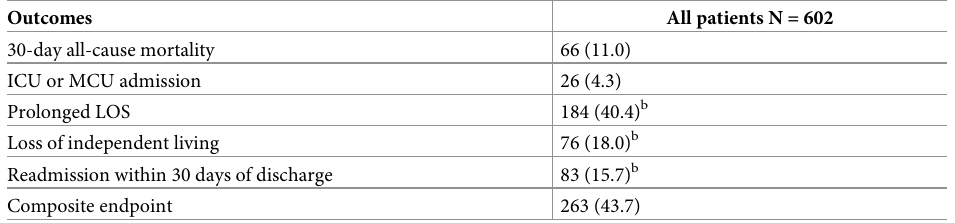
Table 2. Outcomes of study population a .